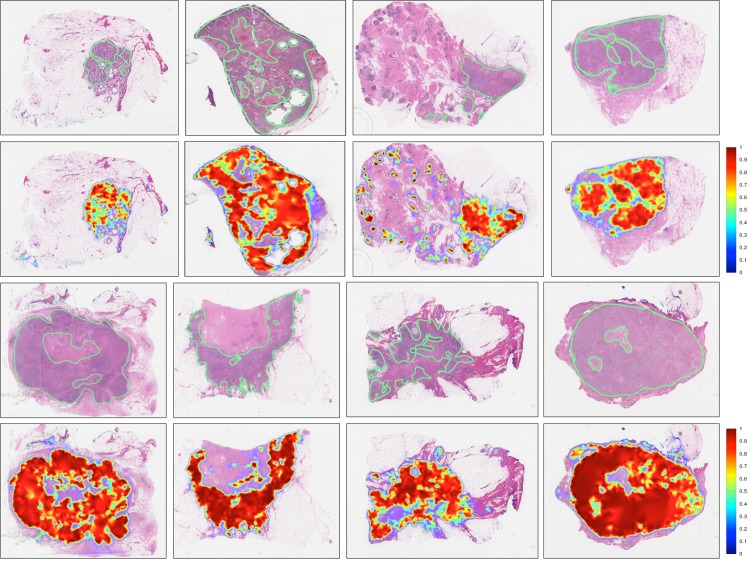
Results of the invasive BCa probability maps (second and fourth rows) predicted by HASHI on representative WSIs from Dtest compared to the ground truth annotations from expert pathologists (first and third rows).Red regions represent locations identified by HASHI as having a high likelihood of cancer presence while the blue regions represent the lowest likelihood of cancer presence.